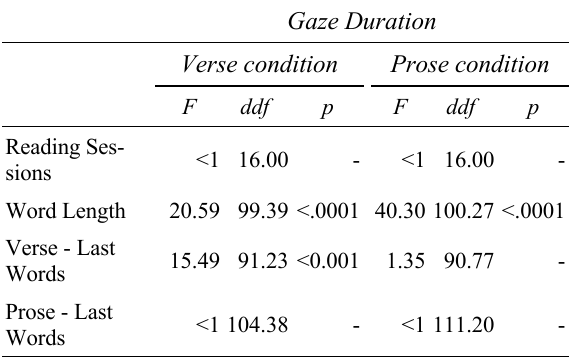
Table 3. Mixed model parameters for the separate analysis (verse vs. prose conditions) for gaze duration reflecting processes of visual word recognition and orthographic/lexical access (lexical